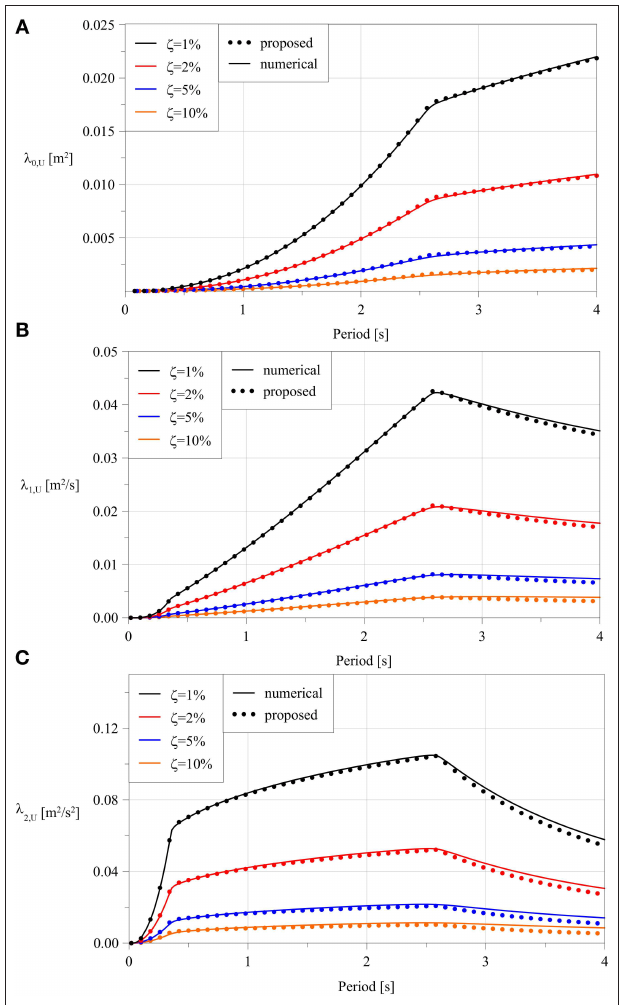
FIGURE 2 | Comparison between the first spectral moments evaluated numerically (solid lines) and by closed-form approximate expressions (dots) against natural period. (A) Zero order moments. (B) first order moments. (C) second order moments.